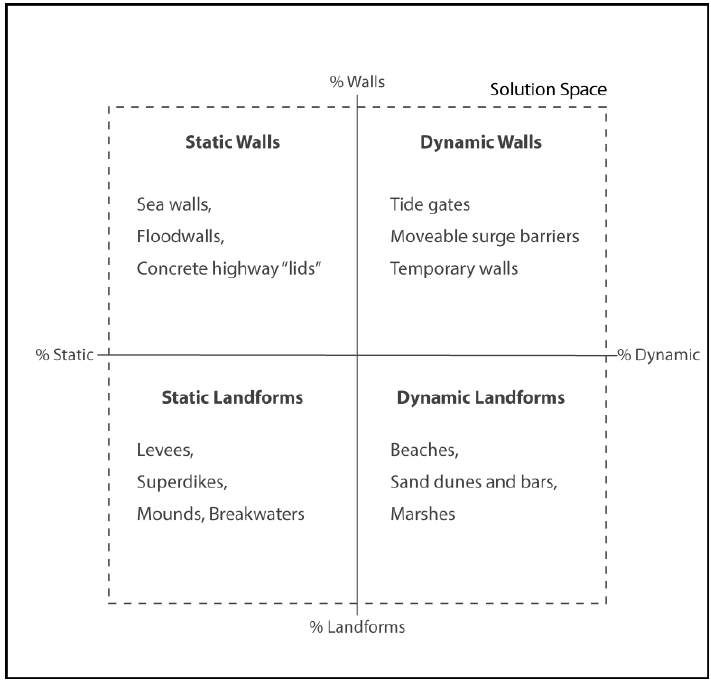
Figure 1. This four-quadrant diagram presents a typology of coastal protective shoreline structures [26]. The vertical axis is defined by the percentage of shoreline that is wall, versus the shoreline that is built with loose materials, such as sand and gravel (landform). The horizontal axis is defined by the percentage of shoreline that is dynamic (able to move, mechanically or by natural processes) versus static (fixed in position). We used this typology in our study because it allows us to differentiate among coastal structures by their approximate initial construction cost, the cost of raising the structures over time, and the variety of ecosystem services they can offer. Structures in the upper right quadrant are typically the most expensive, and structures in the lower right can offer the widest range of